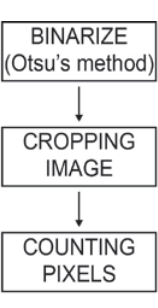
Figure 6. Flow chart from the first method